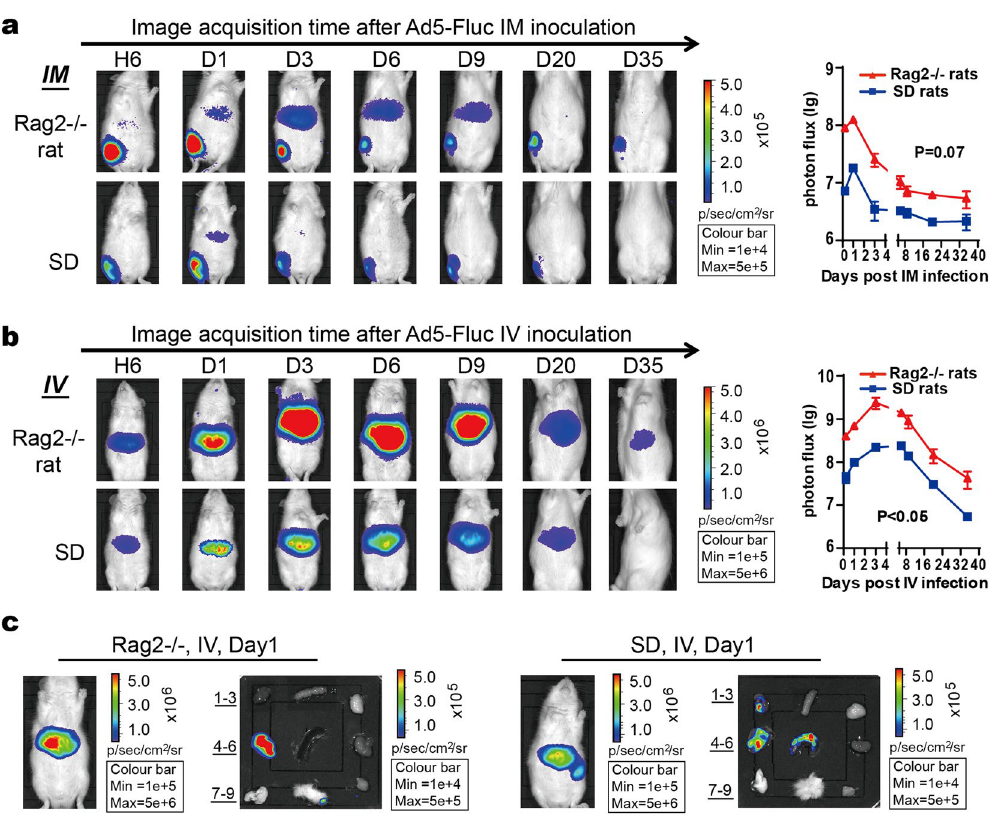
Figure 2. In vivo imaging of luciferase expression after inoculation of wildtype SD and immunodeficient Rag2 − / − rats with Ad5-Fluc. ( a,b ) Four-week-old wildtype SD and immunodeficient Rag2 − / − rats (n = 4/ group) were inoculated with 5 × 10 10 pfu/kg Ad5-Fluc via the IM ( a ) or IV ( b ) route. Bioluminescent images of a representative rat from each group at different time points following inoculation are shown. The relative bioluminescent intensity is shown in pseudo-colour, with red and blue representing the strongest and weakest photon fluxes, respectively. Mean ( ± standard error of the mean) values for the total flux at different time points are shown. The differences between subgroups were calculated using a paired t -test. ( c ) Rag2 − / − and SD rats inoculated with Ad5-Fluc by the IV route were imaged on day 1 post-inoculation. Different organs were dissected and analysed for Fluc transgene expression with BLI: (1) heart, (2) intestine, (3) brain, (4) liver, (5) spleen, (6) kidney, (7) lung, (8) skin, and (9)